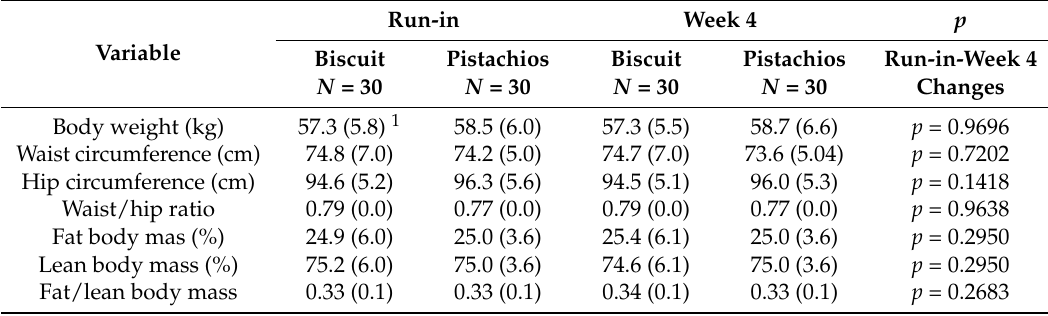
Table 2. Anthropometry and body composition at run-in and after four weeks of consuming either a pistachio or a savory biscuit